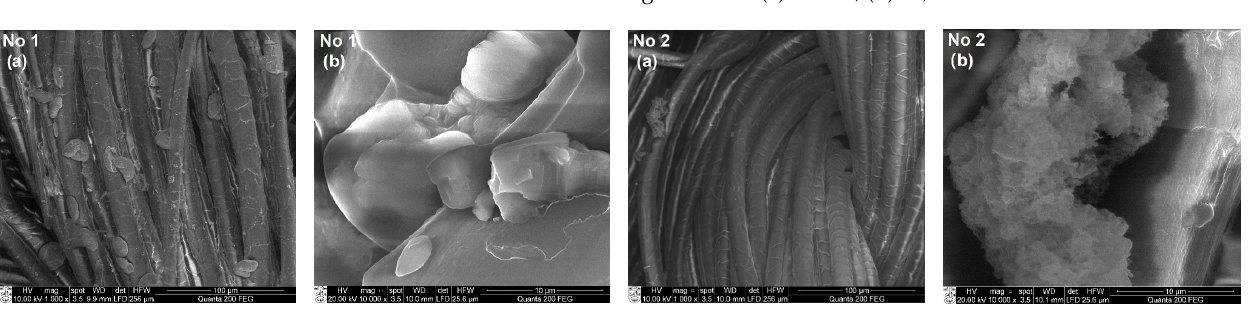
Figure 6. SEM images of knitted fabric materials sample O1 (wool/bamboo viscose, 60/40) treated with solutions No. 1 and No. 2. Magnification: ( a ) 1000 × ; ( b ) 10,000 × .